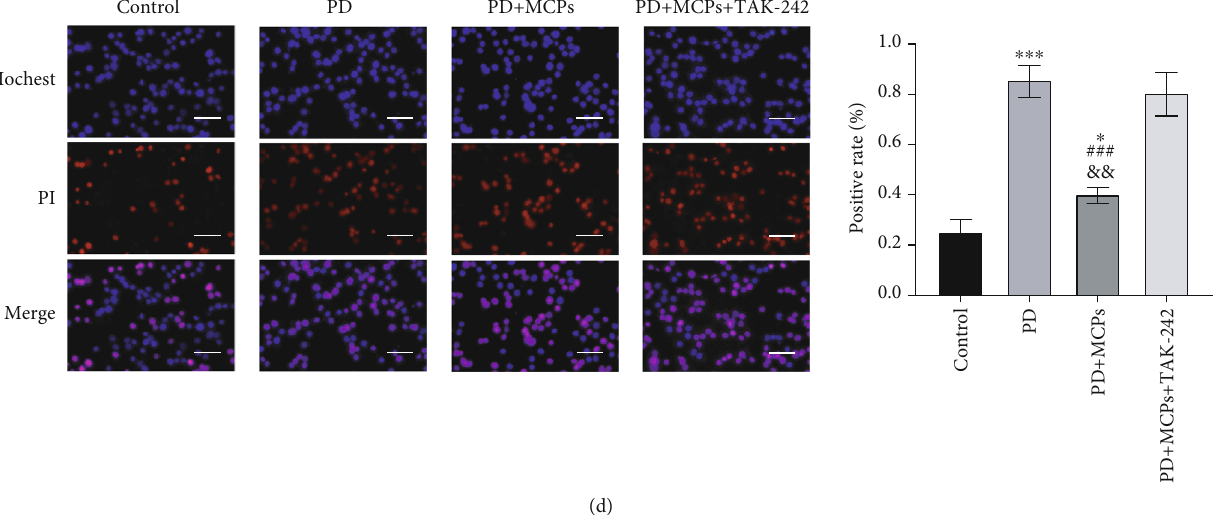
Figure 7: Application of TLR4 inhibitor to verify the e ff ect of MCPs. (a) Validation of TAK-242 inhibitor. (b) Detect the e ff ect of MCPs on cell viability after applying TAK-22. (c, d) Detect the e ff ect of MCPs on cell apoptosis after applying TAK-22. Compared with the Control group, ∗ P < 0 : 05 , ∗∗ P < 0 : 01 , ∗∗∗ P < 0 : 001 , compared with the PD group, ## P < 0 : 01 , ### P < 0 : 001 , similar to PD+TAK-242 Ratio, && P < 0 : 01